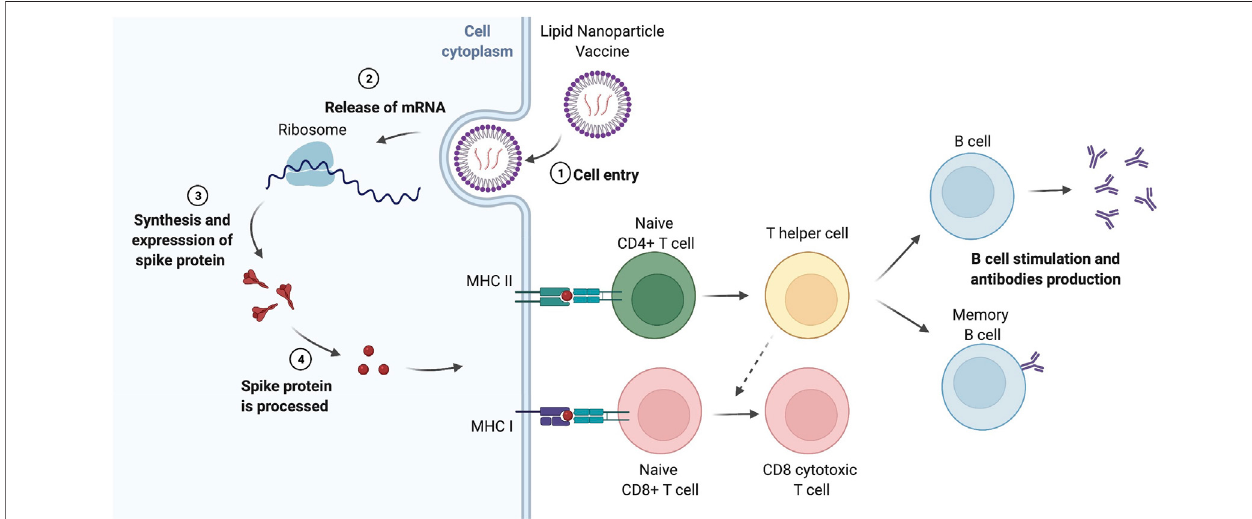
FIGURE 1 | Lipid nanoparticle-based vaccines. After intramuscular injection, lipid nanoparticle (LNP) vaccines are recruited by tissue-resident dendritic cells (DCs) or resident-somatic cells (muscle cells), which translate the mRNA into proteins that are processed leading to the generation of peptide epitopes derived from the spike protein of the virus (Rijkers et al., 2021). The antigens are presented on MHC I (in the case of resident-somatic cells) and MHC II (for antigen-presenting cells including DCs) to naïve CD8 + T cells and naïve CD4 + T cells, respectively, which elicit the immune response against SARS-CoV-2. T helper cells differentiated from naïve CD4 + T cells stimulate the proliferation and differentiation of B cells in memory B cells and plasma cells, the latter secreting antibodies against the spike protein. On the other hand, naïve CD8 + T cells, with the assistance of T helper cells, produce CD8 cytotoxic T cells, responsible for the killing of the infected cells. Memory T cells (not shown) are also generated, and they are also important for the long-term protection against infection. It is worth remarking some LNPs can drain to the closest lymph nodes and interact, directly, with the resident immune cells and activate the T and B cells. Moreover, muscle cells in the injection site can also internalize the LNPs, process the mRNA and express the speci fi c antigens on MHC class I, participating in the CD8 + T cell activation (Hou et al., 2021). The fi gure was prepared using